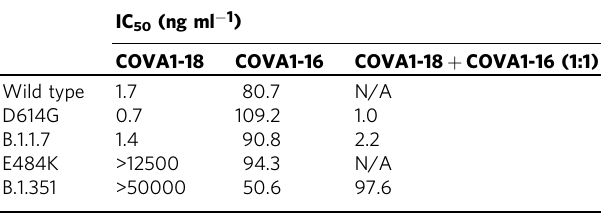
Table 2 COVA1-18 and COVA1-16 neutralization potency against variants in HEK293T hACE2 cells.